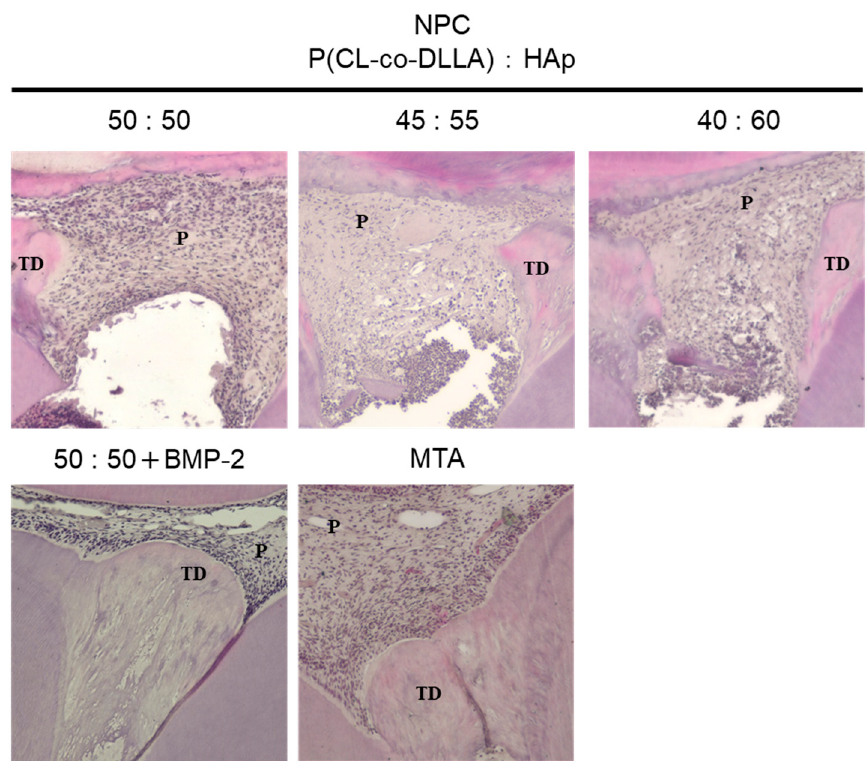
Figure 5. Representative histological images (HE staining) of tertiary dentine. Images taken after capping with several ratios of HAp NPC, NPC (50:50) with BMP-2, and MTA for 4 weeks. Sagittal sections are shown. The tertiary dentine covered application area was induced beneath NPC (50:50) with BMP-2 and MTA. A, apical; C, cavity; D, distal; M, mesial; O, occlusal; P, pulp; TD, tertiary dentine. Table 2. Summary of the histological score for tertiary dentin formation. Group Samples